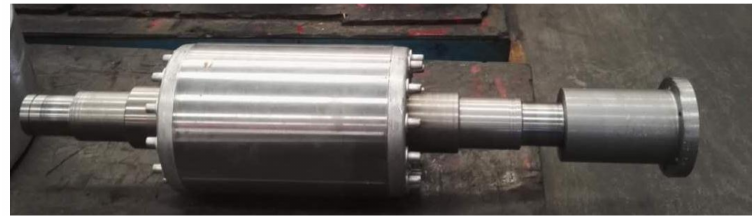
Figure 16. Photographs of the fabricated rotor.